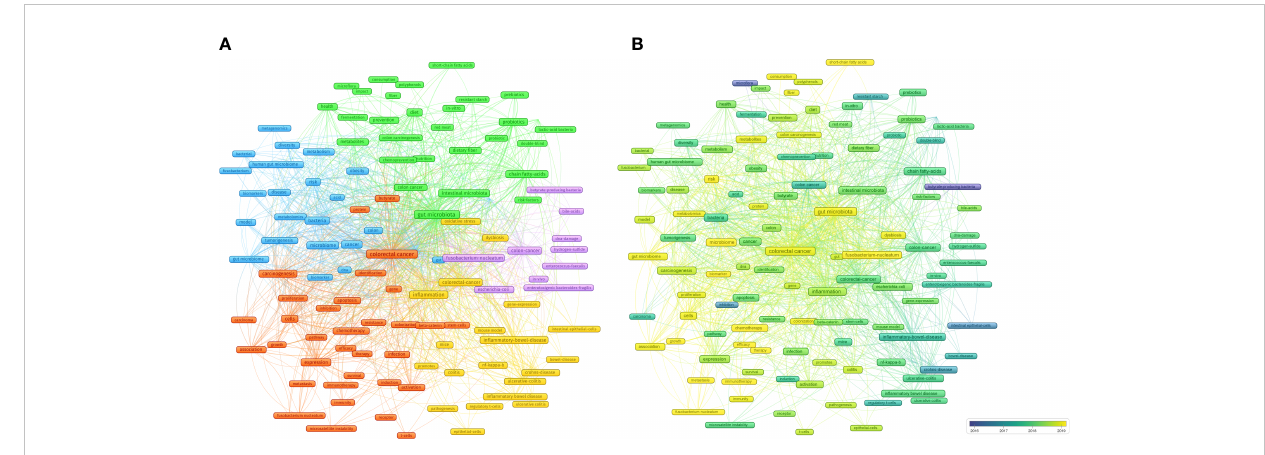
FIGURE 8 (A) Cluster analysis of common keywords in IM/CRC (different colors signify different clusters, and sizes of the circle signify the frequency of keyword occurrence). (B) Evolution trends of common keywords over time in IM/CRC (blue boxes signify the early keywords and yellow boxes signify the late